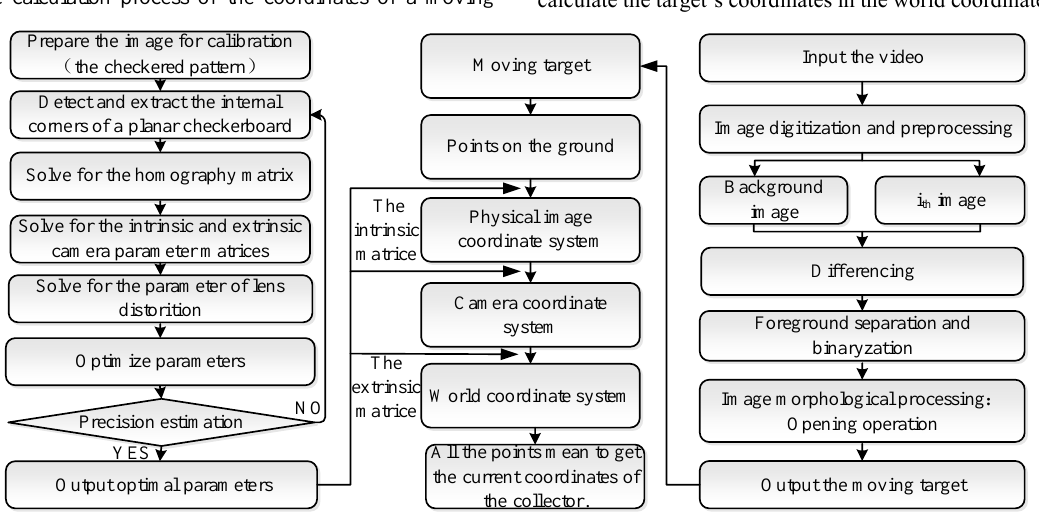
Figure 2 . Calculation process of the coordinates of a moving target.